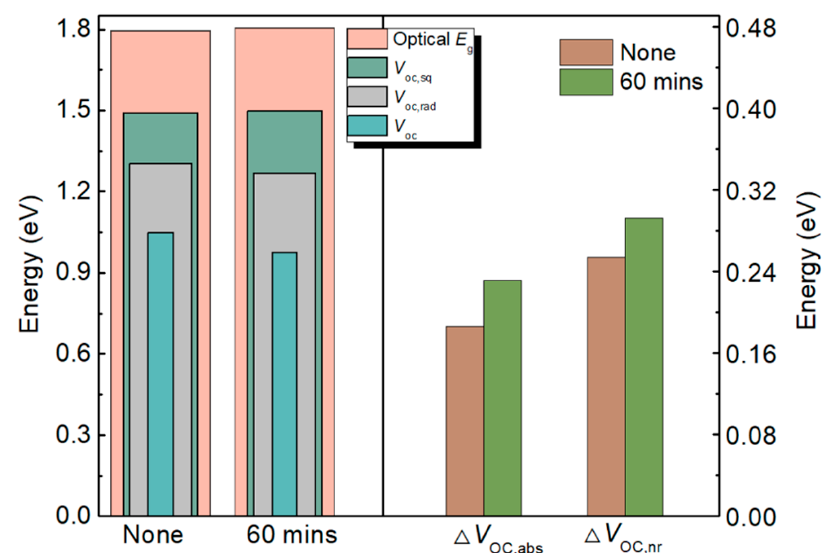
Figure 5. Comparison of the optical bandgap, SQ limit for V OC , radiative V OC , and V OC for PCDTBT:bis-PCBM OPVs before and after degradation under 300 lx for 60 min. The Δ V OC,abs = V OC,sq − V OC,rad and Δ V OC,nr = V OC,rad − V OC .